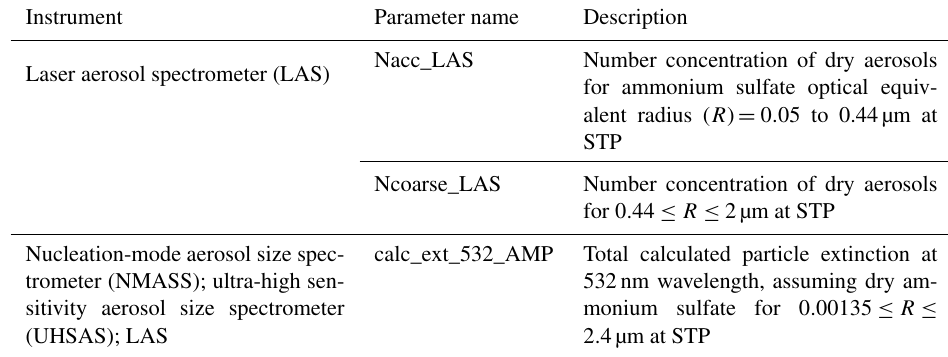
Table 1. Details of the ATom parameters used in the comparison study. Note: STP is standard temperature and pressure. Instrument